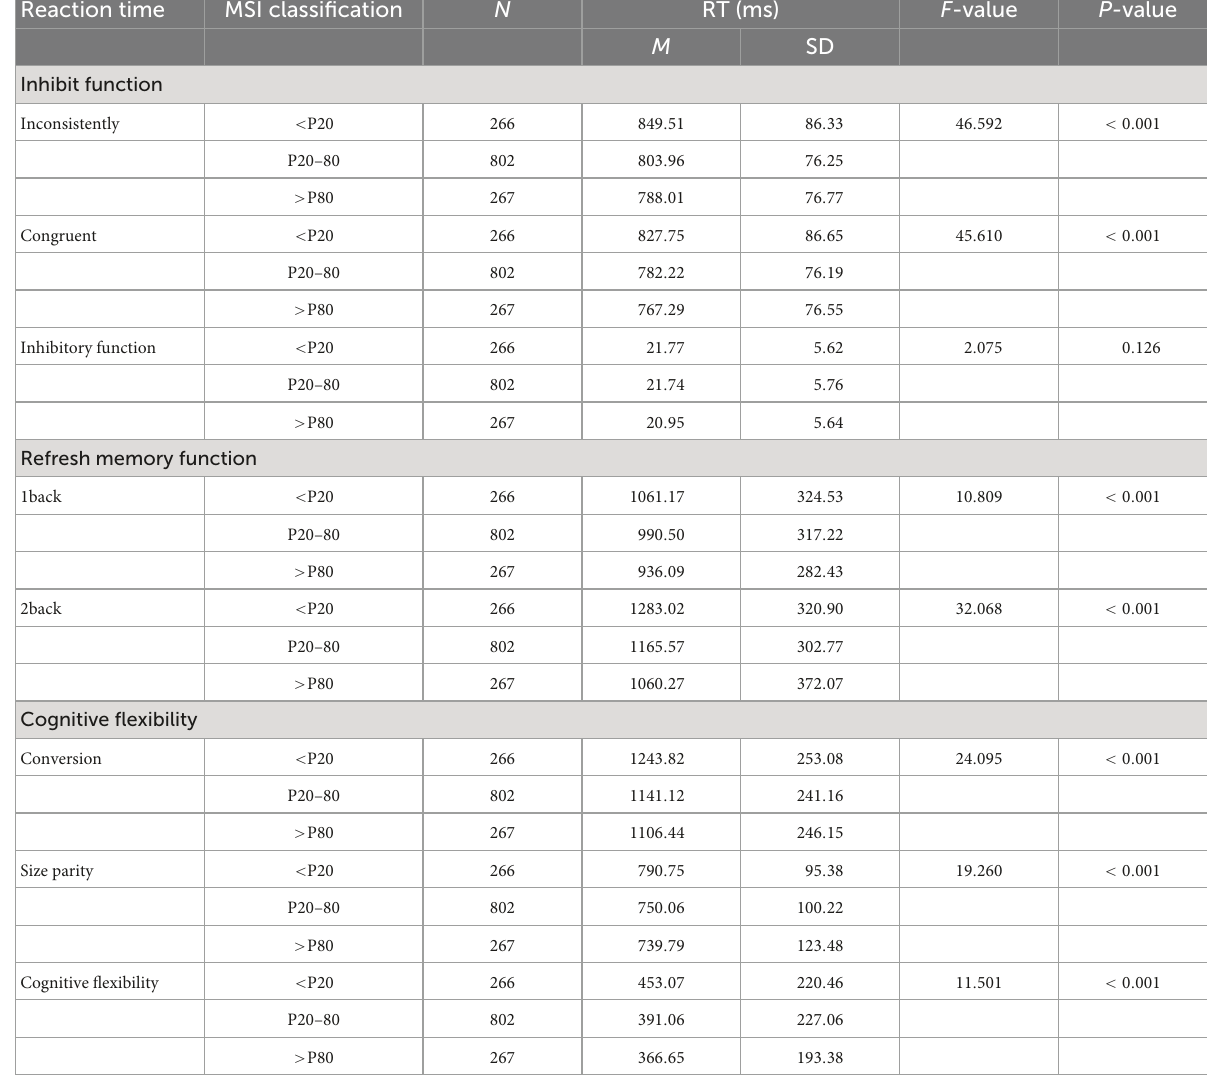
TABLE 2 Comparison of the reaction times of children and adolescents with different muscle strength indexes in executive functions in rural areas of China. Reaction